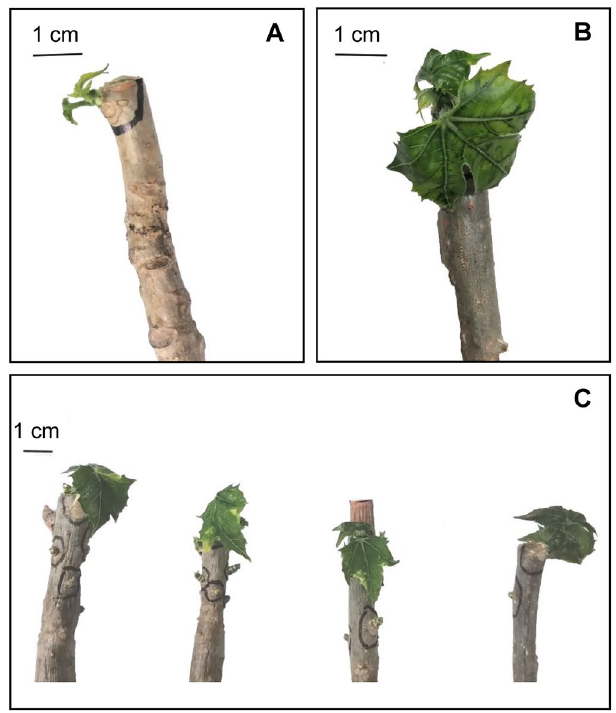
Figure 4. Stem cuttings from a wild ( A ) and a domesticated ( B ) Cnidoscolus aconitifolius 6 weeks after having been cut. Although the cuttings in ( A) and ( B ) are the same age, the differences in terms of the degree of development of leaves is noteworthy. ( C ) Surviving cuttings of domesticated plants after 120 days, all of which were obtained from domesticated plants and were completely deprived of substrate and water. Scale bars represent 1 cm in all cases.